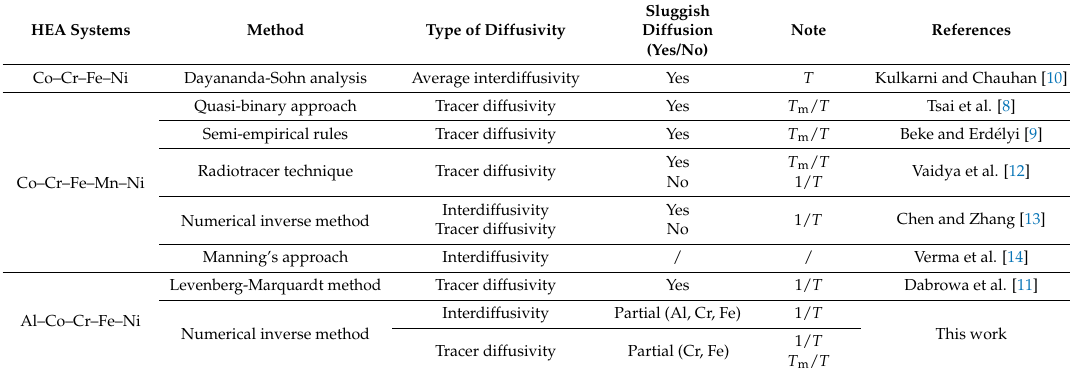
Table 1. Summary of experimental information on diffusivities in different high-entropy alloys (HEAs) available in the literature and in the present